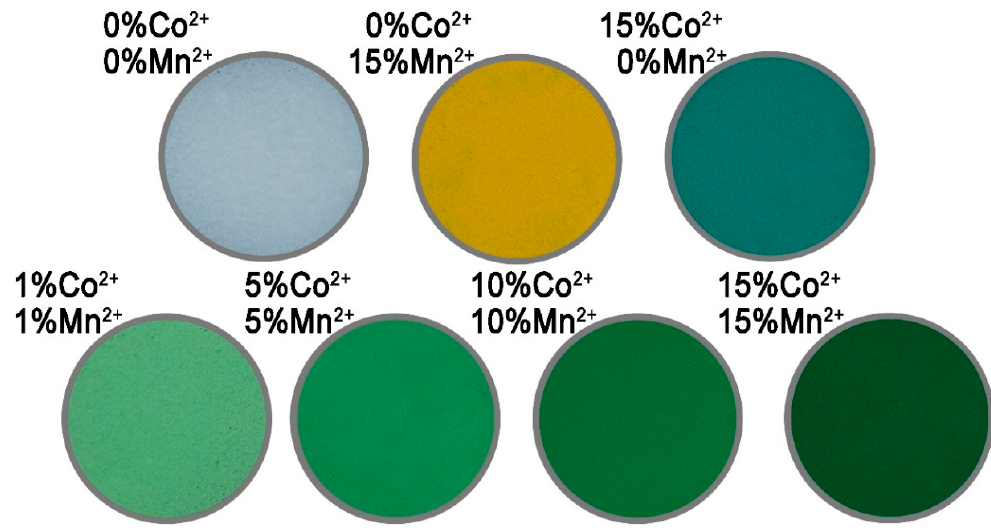
Figure 8. Photos of dry powders of Zn (1 − x − y) Mn x Co y O.